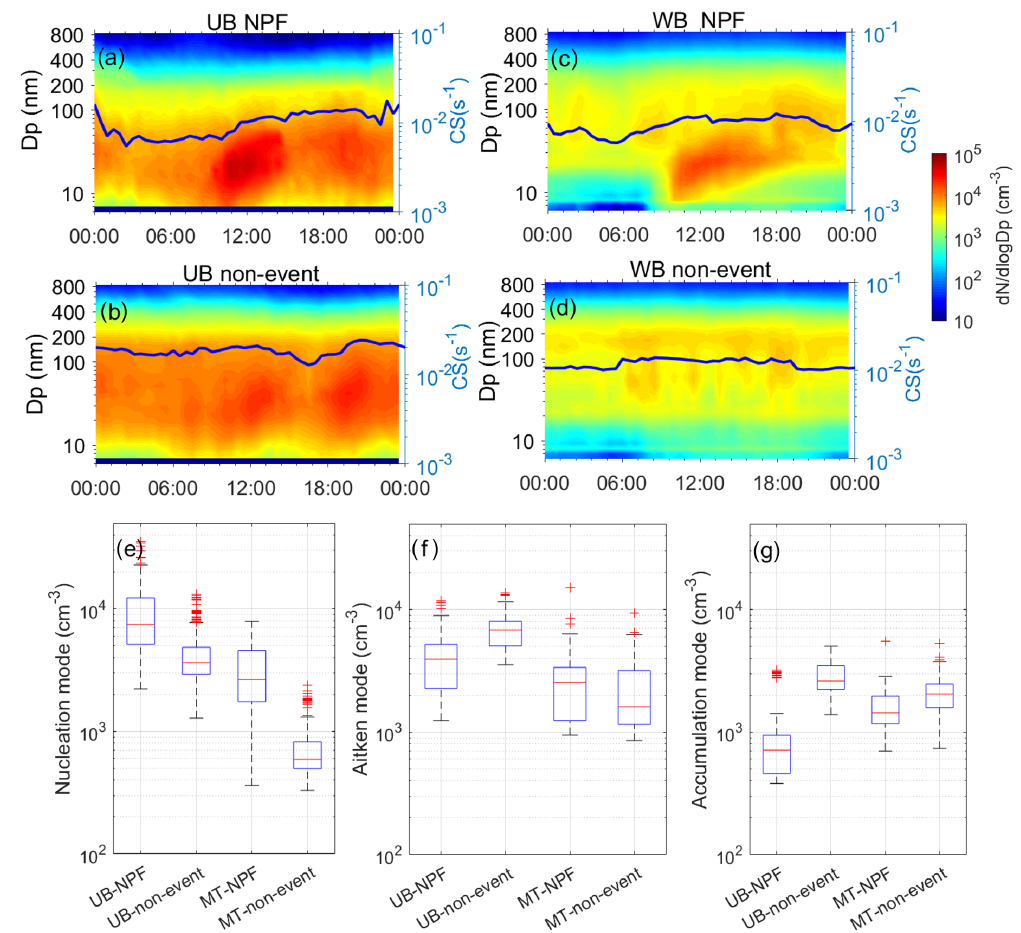
Figure 14. Median particle number size distribution as well as CS (blue lines) on NPF event and non-event days at UB (a, b) and MT (c, d) stations and median and percentiles of nucleation- (e) , Aitken- (f) and accumulation-mode (g) particle number concentration on NPF event and non-event days during our observation from 14 June to 14 July 2019 at both stations. The red line represents the median of the data, and the lower and upper edges of the box represent 25th and 75th percentiles of the data, respectively. The length of the whiskers represents 1.5 times the interquartile range, which includes 99.3% of the data. Data outside the whiskers are considered outliers and are marked with red